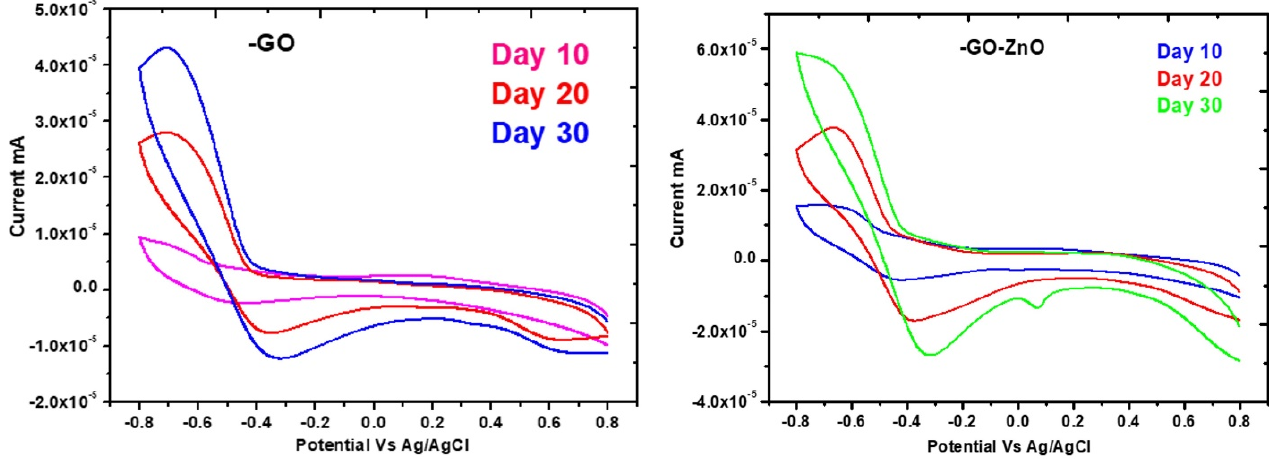
Table 2. Cp values of GO and GO-ZnO anode CV curves.